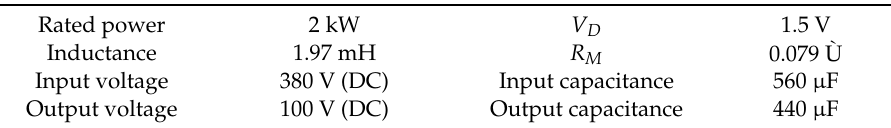
Table 1. Specifications of the